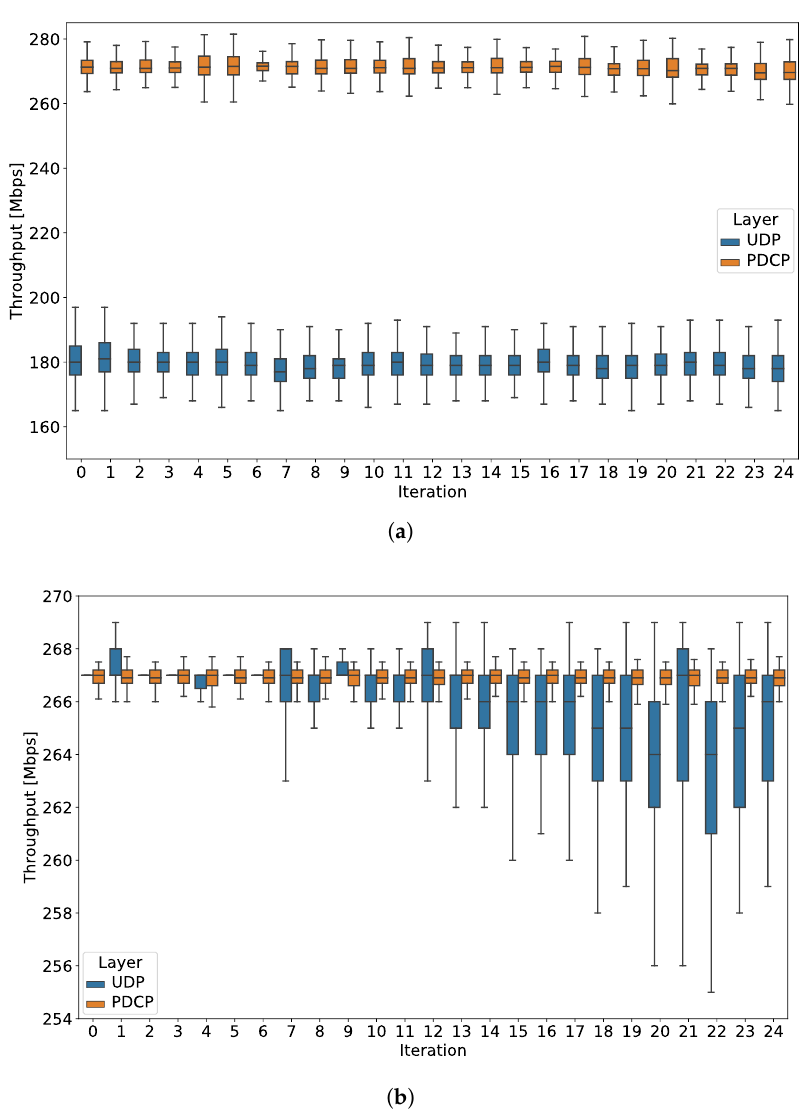
Figure 6. Experiment 3: UDP and PDCP Throughput per-iteration statistics for TC_THR_UDP test case and SC_LoS_PS scenario. Results for UE_1 and UE_2 are reported in ( a , b ),